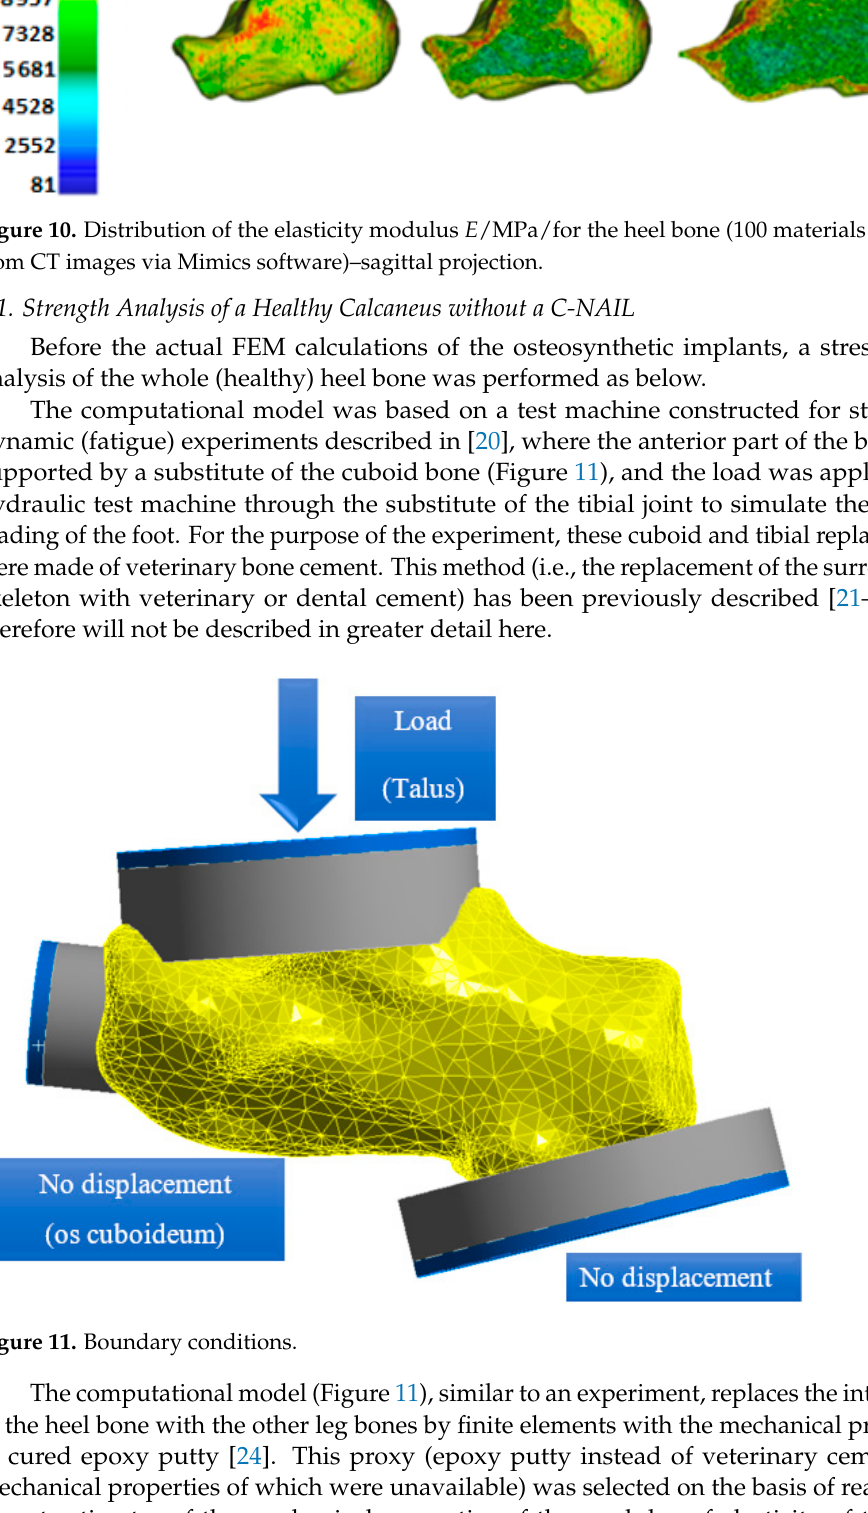
Figure 9. Distribution of the elasticity modulus E /MPa/for the heel bone (100 materials acquired from CT images via Mimics software)–transversal projection.